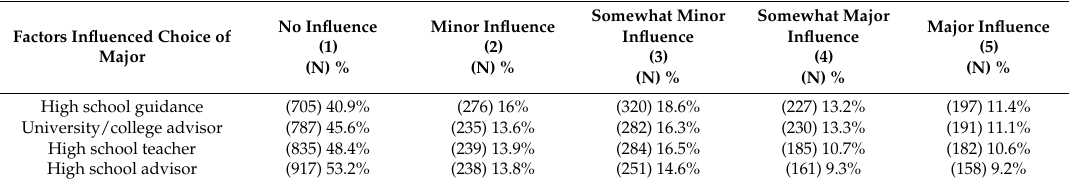
Table 3. Factors Influenced Major Chosen for all four years together (related to student academic advising issue N =